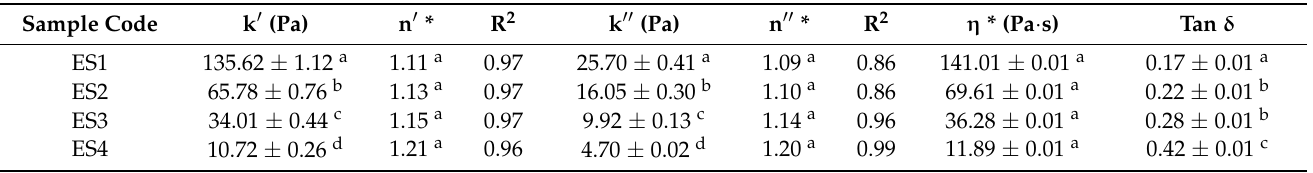
Figure 4. Mechanical spectra obtained in the dynamic oscillatory test of the dressing emulsion stabilized with hydrocolloids from butternut squash seeds at pH 10. ( a ) Loss and storage modulus, ( b ) complex viscosity, and ( c ) loss tangent. Table 6. Viscoelastic properties of the dressing emulsion stabilized with hydrocolloids from butternut squash seeds at pH 10 evaluated at a constant frequency within the linear viscoelastic region in the dynamic oscillatory test. Storage modulus ( G (cid:48) ), loss modulus ( G (cid:48)(cid:48) ), tan δ ( G (cid:48) / G (cid:48)(cid:48) ), and complex viscosity ( η *) at 1 rad · s − 1